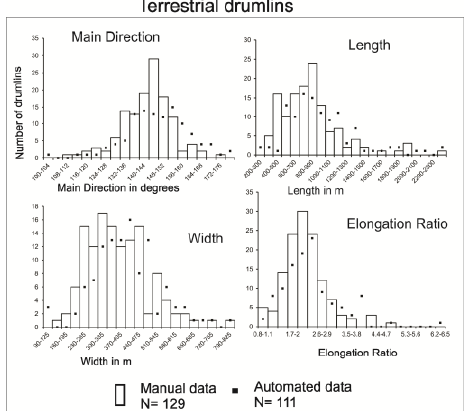
Figure 11. Comparing morphometric parameters of the automatically and manually delineated drumlins in the terrestrial environment (Saha et al. 2011).